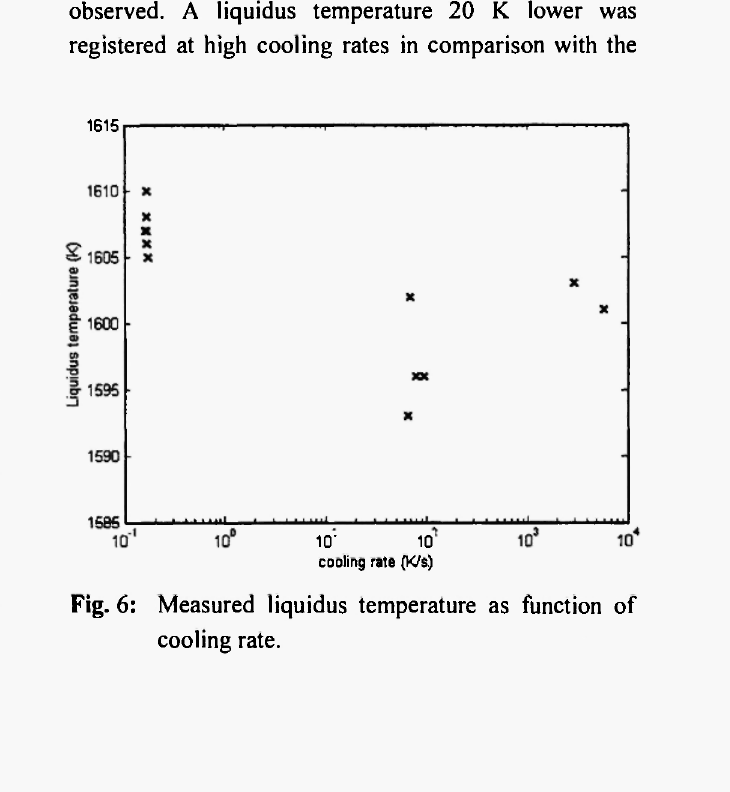
Fig. 5: Solid fraction as function of temperature for modified In625.